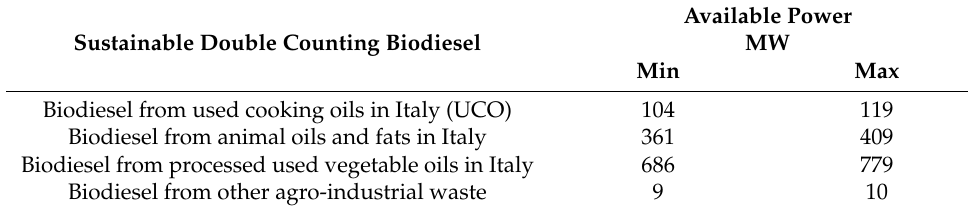
Table 2. Power of sustainable double-counting